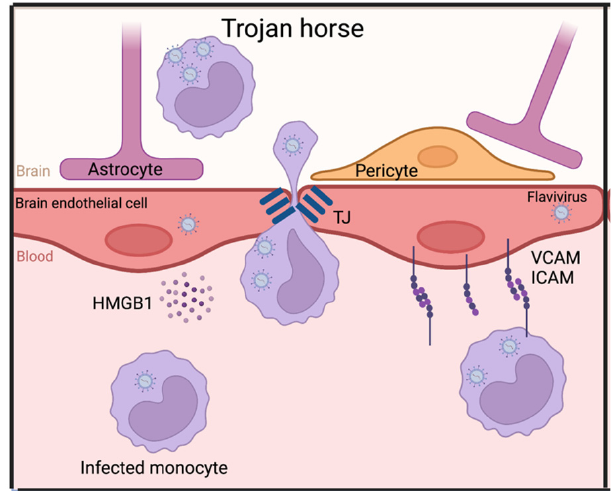
Figure 3. Flaviviruses bypassing an intact BBB via the “Trojan horse” principle. Abbreviations: HMGB1: High ‐ mobility group box 1, VCAM: Vascular cell adhesion molecule, ICAM: Intercellular adhesion molecule. Made in Biorender.